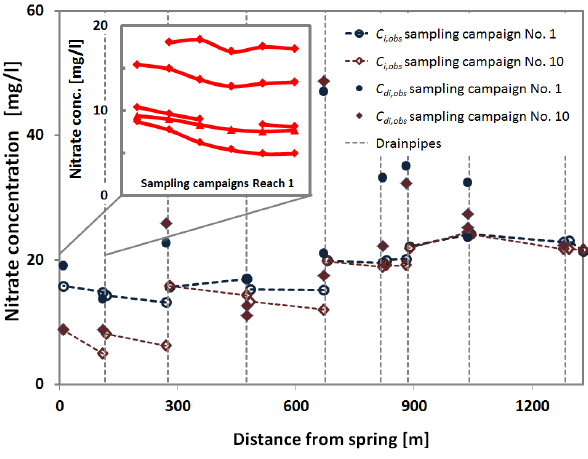
Figure 2. Observed spatio-temporal variations in in-stream and drainpipe nitrate concentrations along the stream network for sam- pling campaigns No. 1 (27 June 2012) and No. 10 (9 August 2012) and during five sampling campaigns at Reach 1